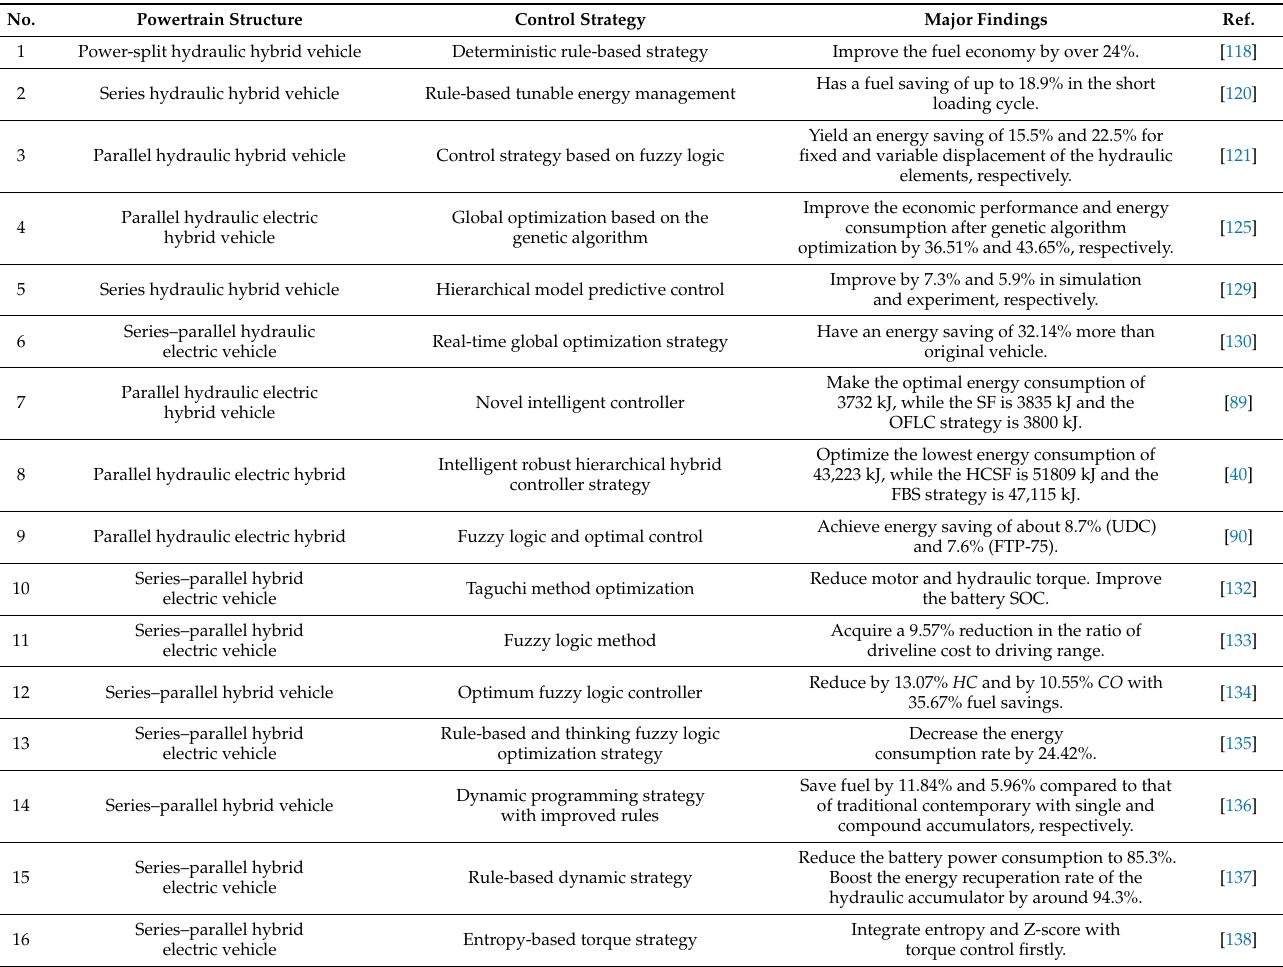
Table 7. Summary of control approaches used for mechanical–electric–hydraulic hybrid energy storage systems in typical